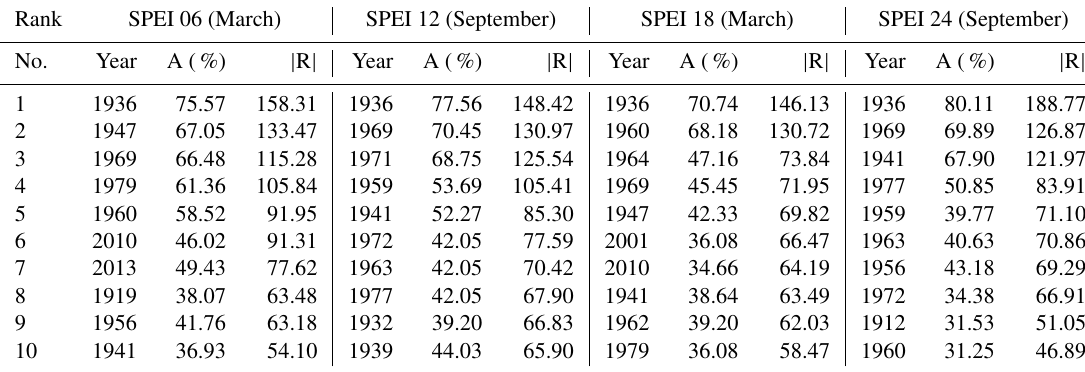
Table 2. The 10 most wet extreme events (top 10) for each timescale. Absolute final rank index | R | for the 6-month timescale obtained for March (SPEI 06), for the 12-month timescale obtained for September (SPEI 12), for the 18-month timescale obtained for March (SPEI 18), and for the 24-month timescale obtained for September (SPEI 24). “A” represents the area (in percent) where the respective index is above the 1.28